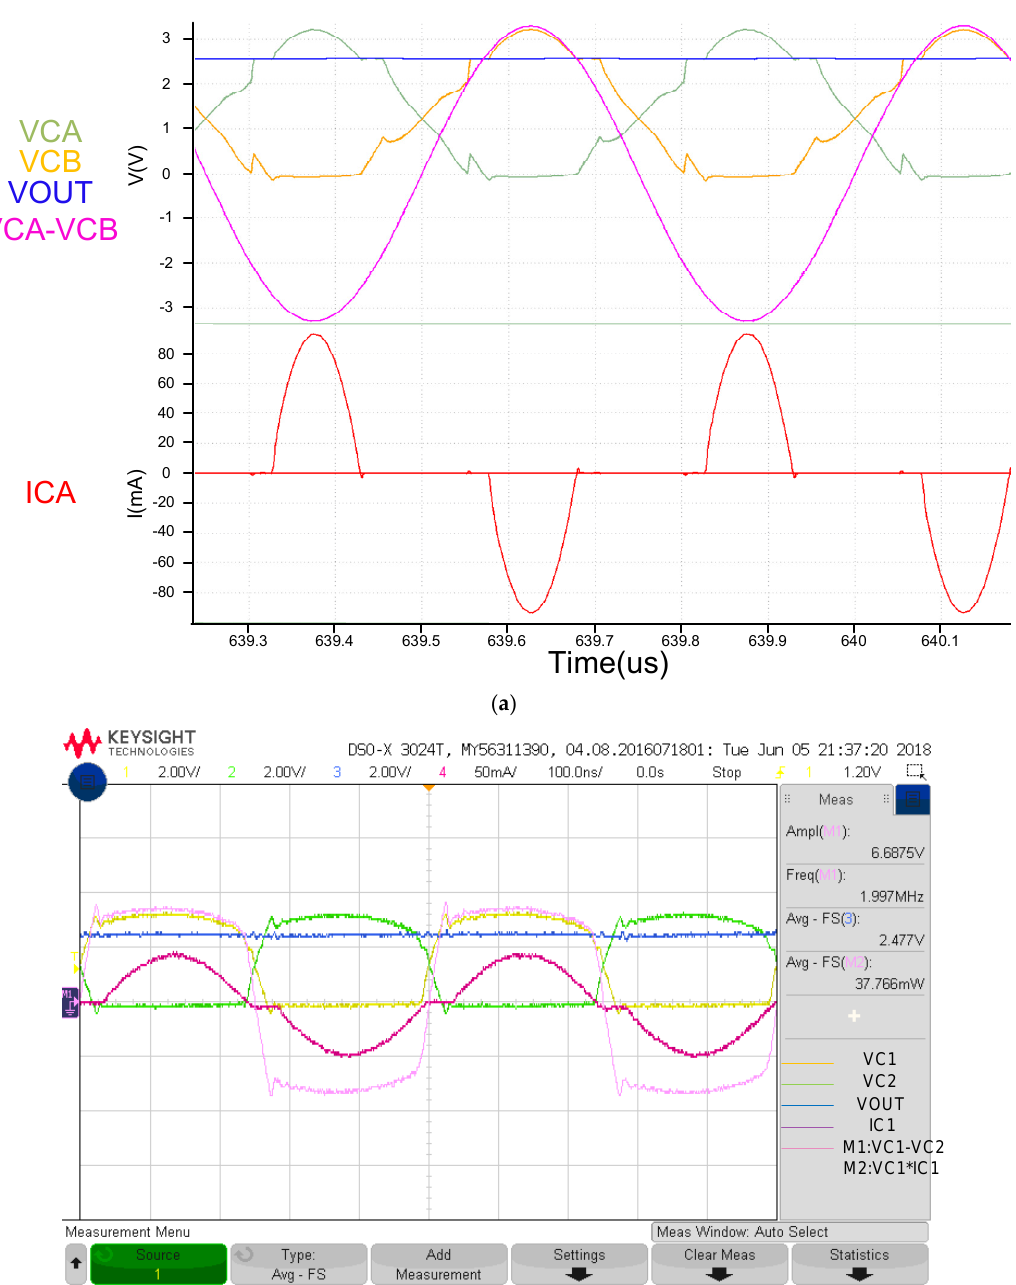
Figure 30. ( a ) simulation waveforms ( 𝑅 (cid:3013) = 1 kΩ including input current); ( b ) Actual measurement board ( 𝑅 (cid:3013) = 1 kΩ including input current).